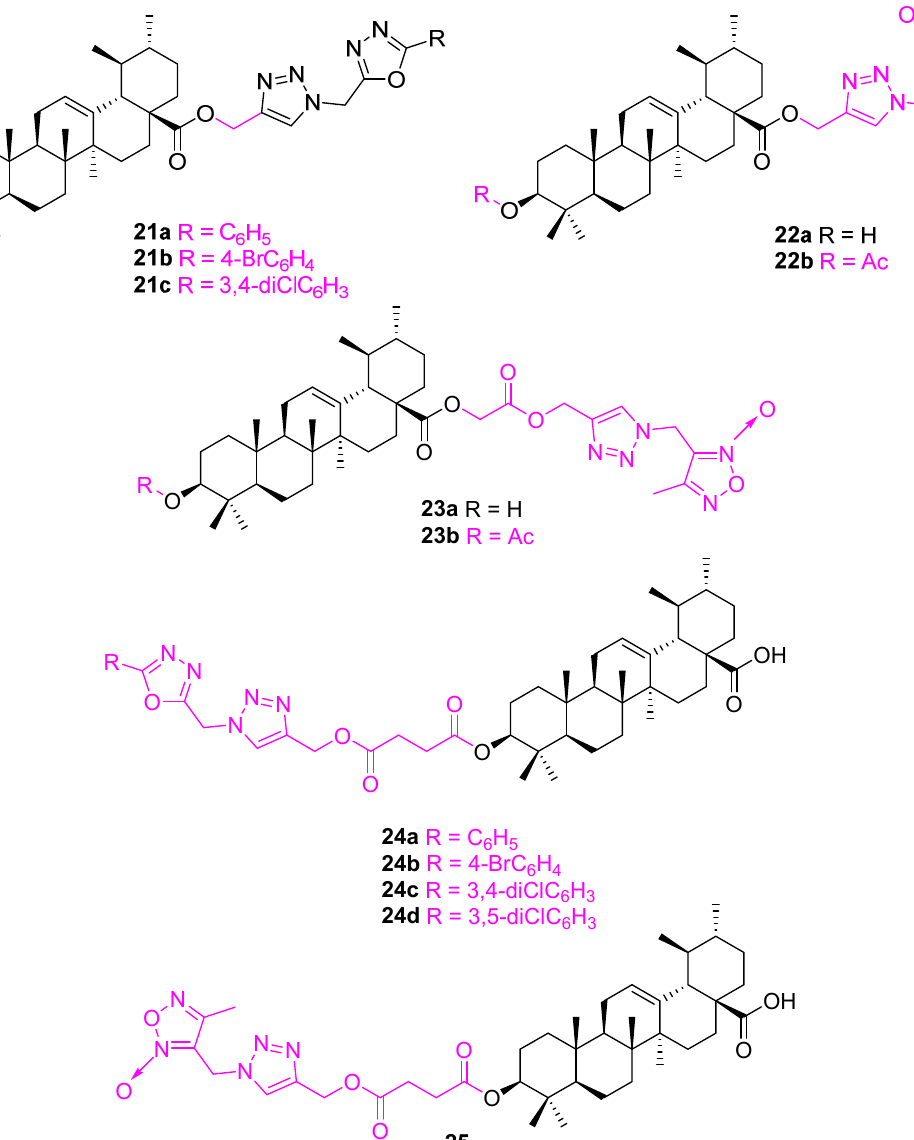
Figure 15. Structure of 21a – c , 22a , 22b , 23a , 23b , 24a – d , 25 . Shao et al. developed several UA analogs, retaining the polar properties at the C3 and C28 positions. Among the several synthesized analogs, compound 26 (Figure 16) showed potential anticancer properties against human hepatoma (HepG2), human gastric cancer (BGC823), human neuroblastoma (SH-SY5Y), human cervical carcinoma (Hela), and human embryonic lung fibroblast (HELF) cell lines. Further, a flow cytometric analysis and morphologic changes study suggested compound 26 arrests cell cycle progression at the S phase in HepG2 cells [85]. The same compound 26 was prepared by another research group, who evaluated its EC 50 values against several cancer cell lines; they validated the potency of 26 , however, it also had a lower ED 50 against the non-malignant fibroblasts NIH 3T3